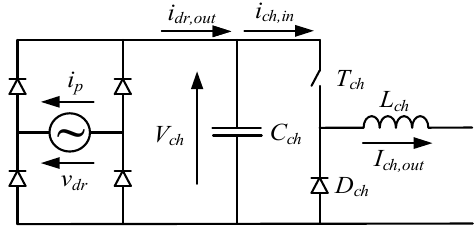
Figure 8. Pickup side conversion stage schematic.